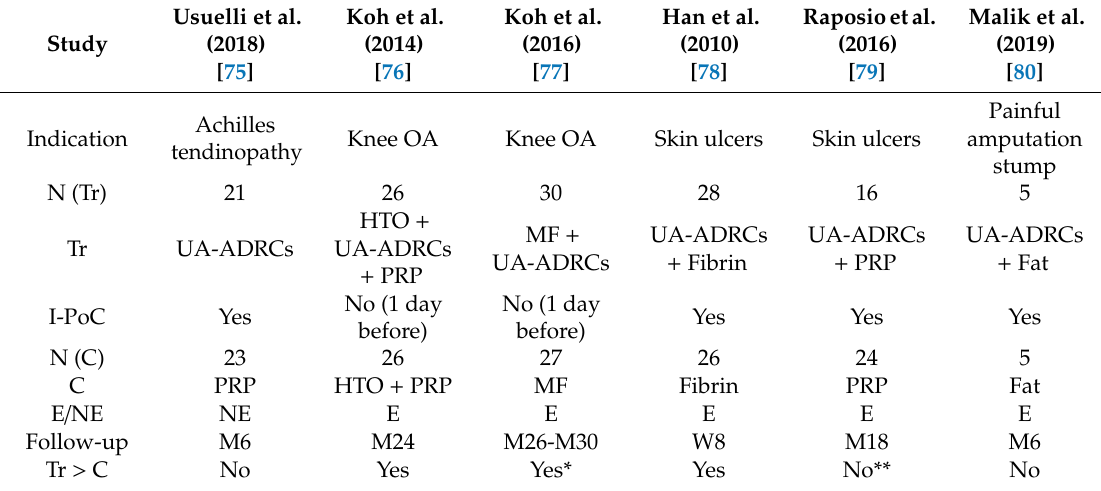
Table 2. Randomized controlled trials (RCTs) for treating various conditions with UA-ADCRs reported in the literature (c.f.